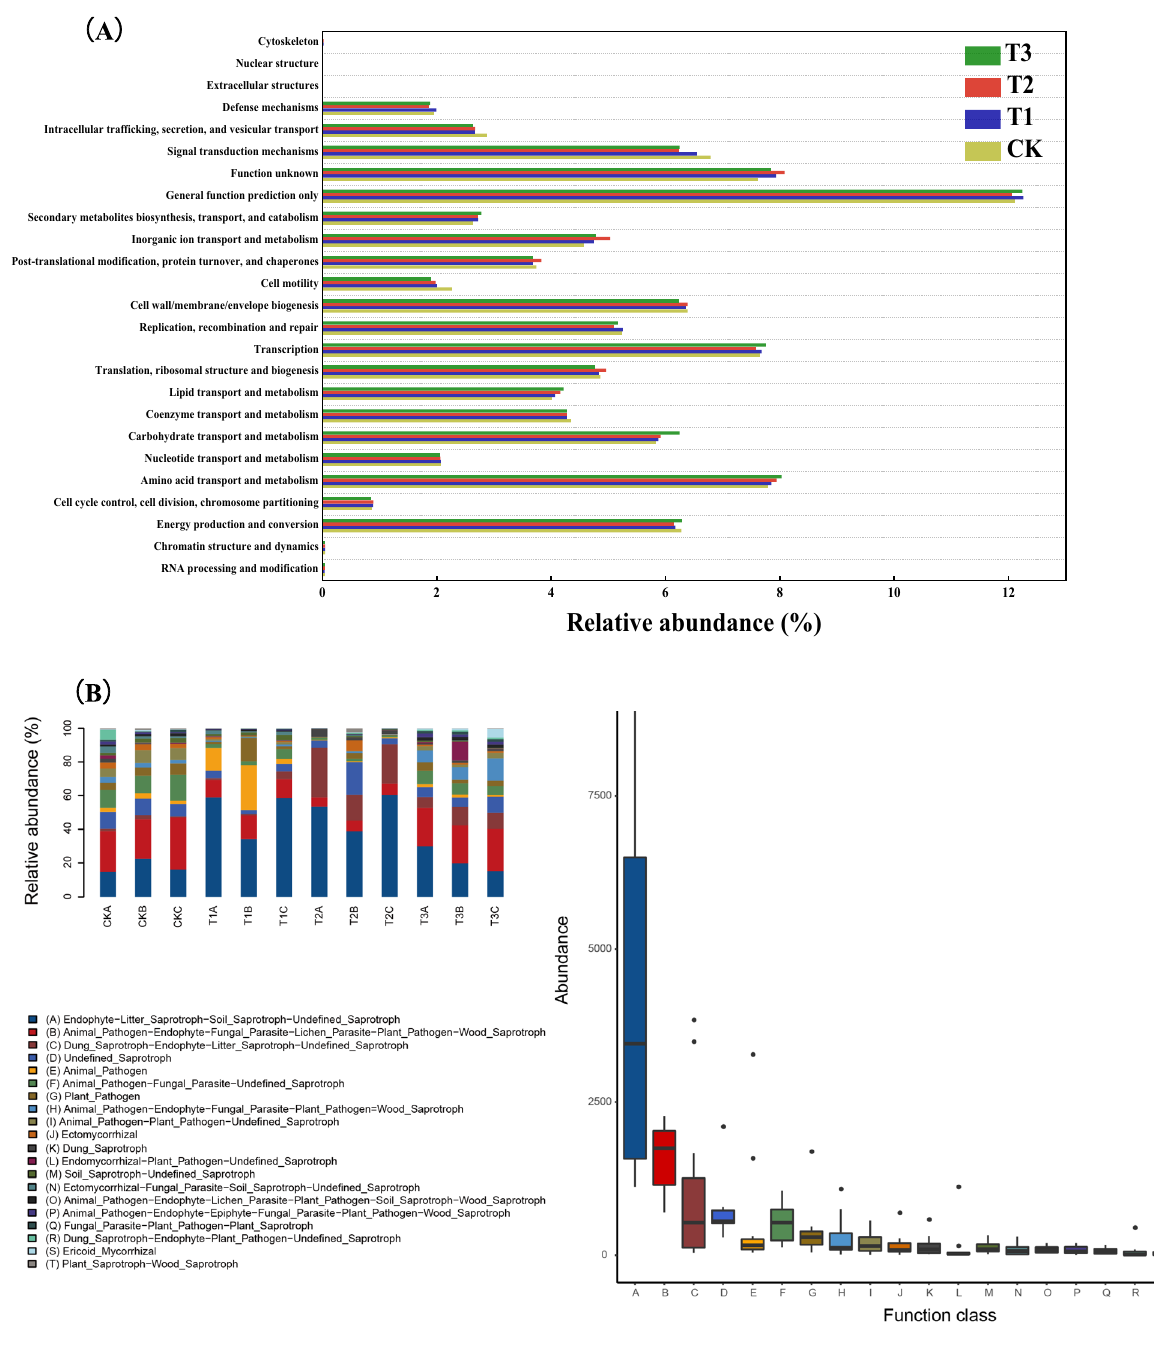
Figure 7. The bacterial functional diversity (A) and fungal functional diversity (B) under JF-1 and maize straw applications.